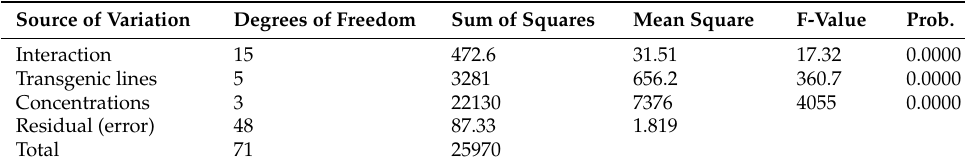
Table 4. Two-way ANOVA for DPPH free radical scavenging assay.